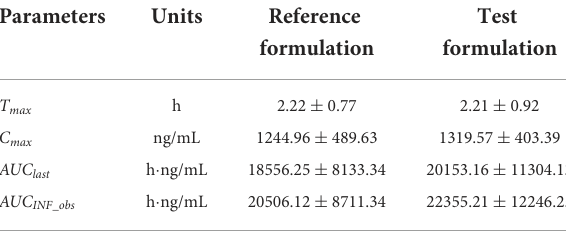
TABLE 2 Pharmacokinetic variables obtained for two formulations of cyclosporine in cats ( n = 24) after a single dose of 7 mg/kg orally. Parameters